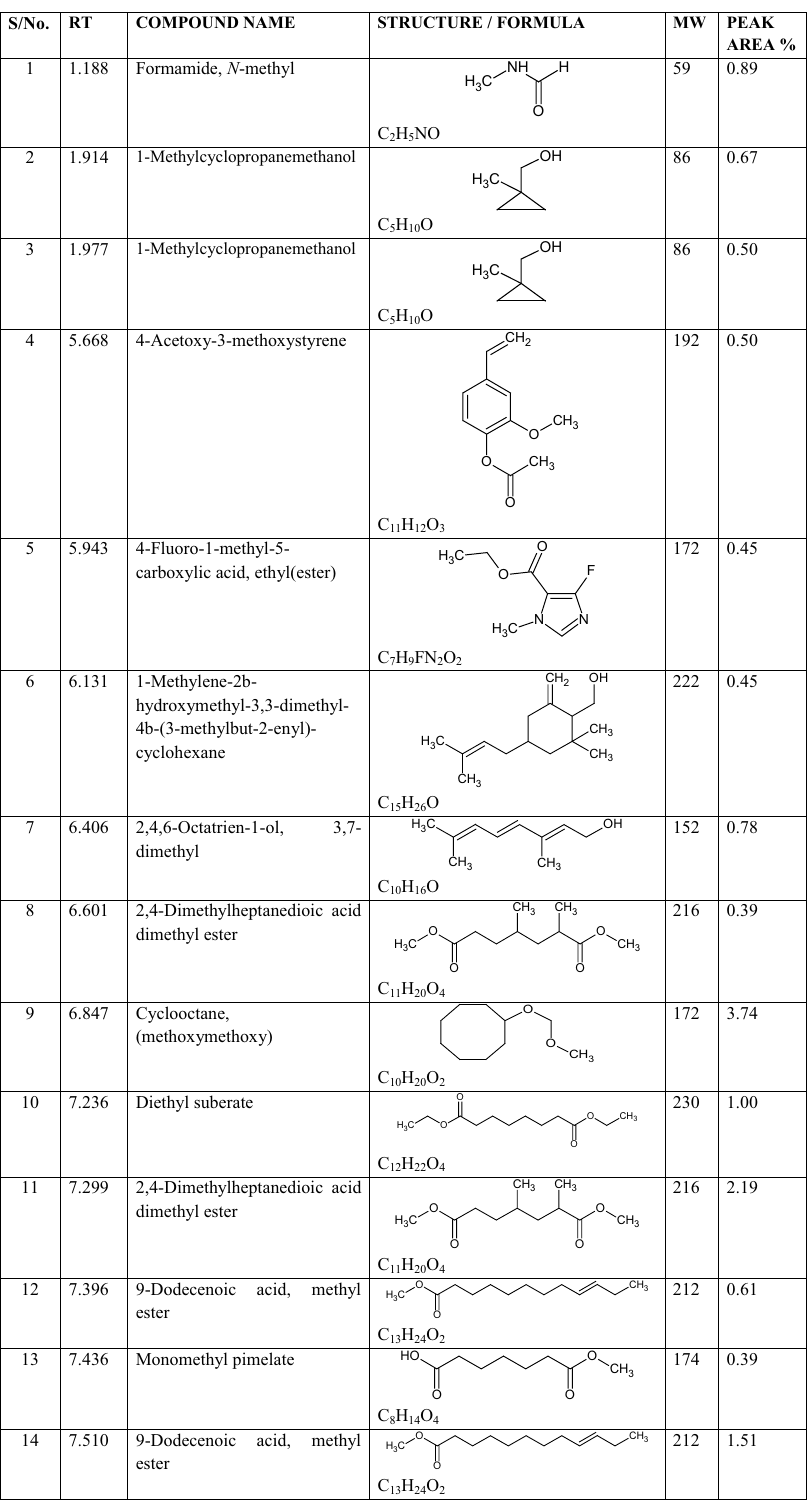
Table 1 Phytoconstituents of the ethyl acetate root bark extract of S. innocua S/No.